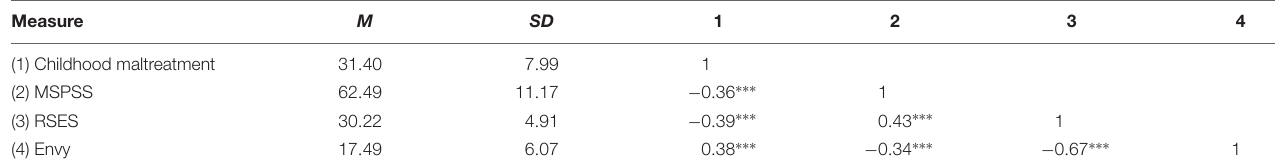
TABLE 1 | Descriptive statistics and zero-order correlations for all